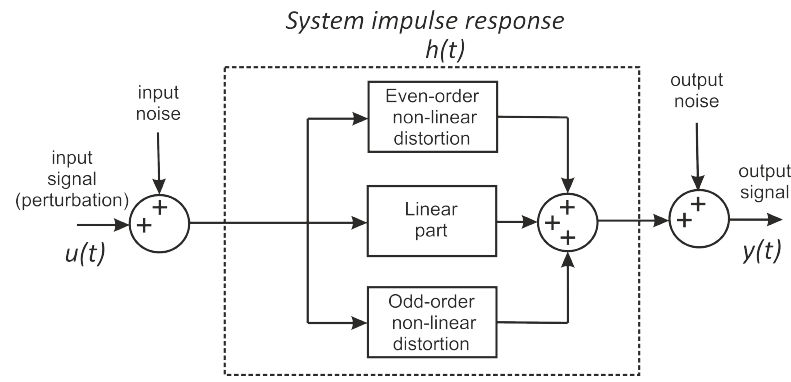
Figure 1. Typical nonlinear system